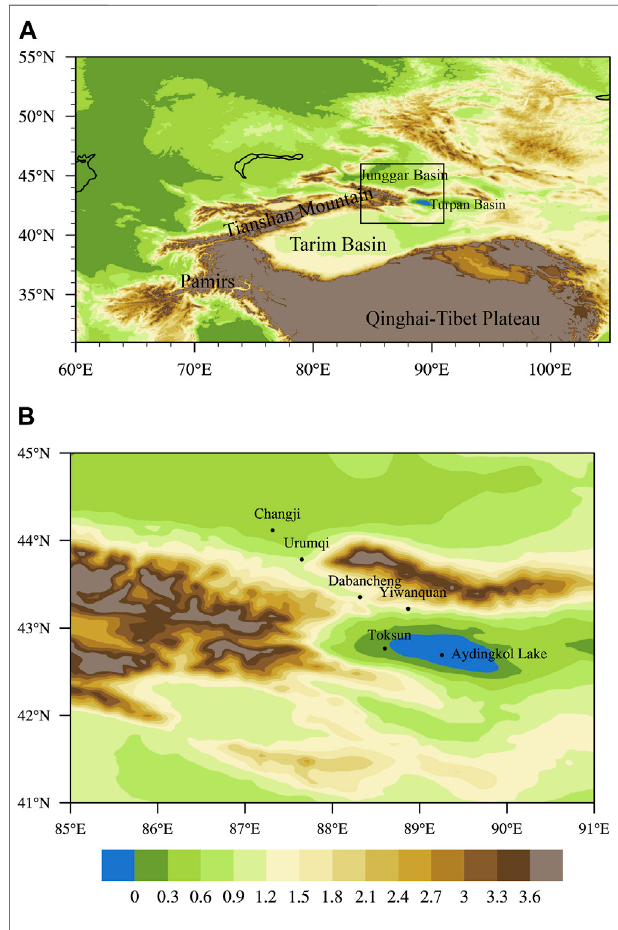
FIGURE 1 | Topography in (A) Northwest China and surrounding area andintheregionof (B) TianshanGrandCanyon(TGC).Thelocationsofthesix automatic weather stations are indicated by dots in (B)